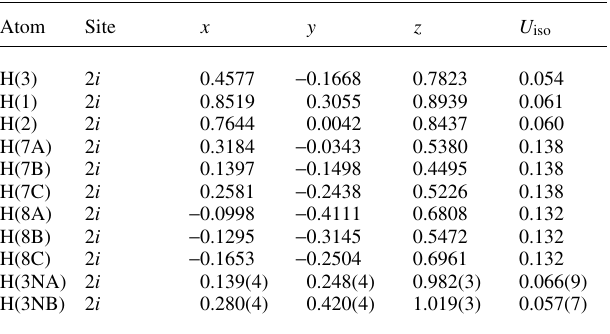
Table 2. Atomic coordinates and displacement parameters (in Å 2 ) .